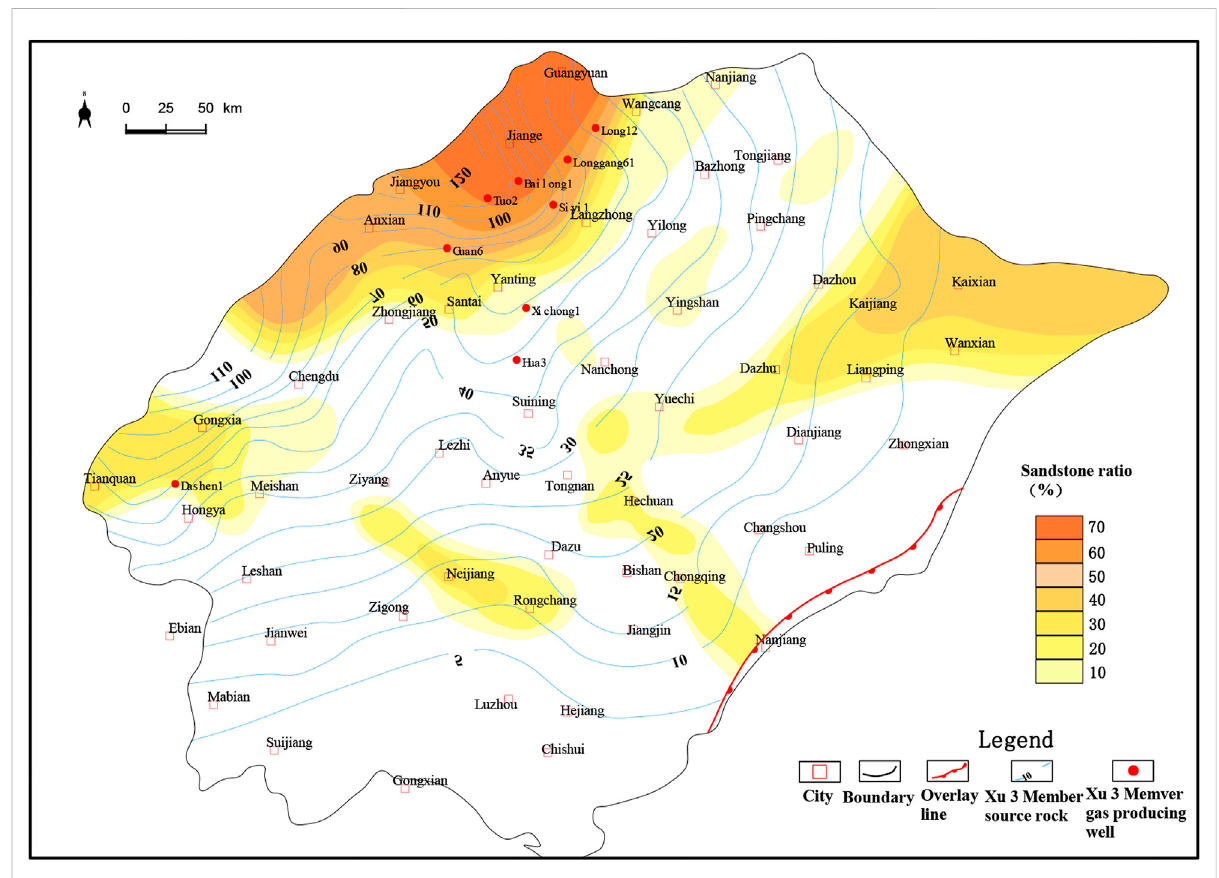
FIGURE 10 Superposition of source rock thickness and sandstone ratio of Xujiahe Formation in the Sichuan